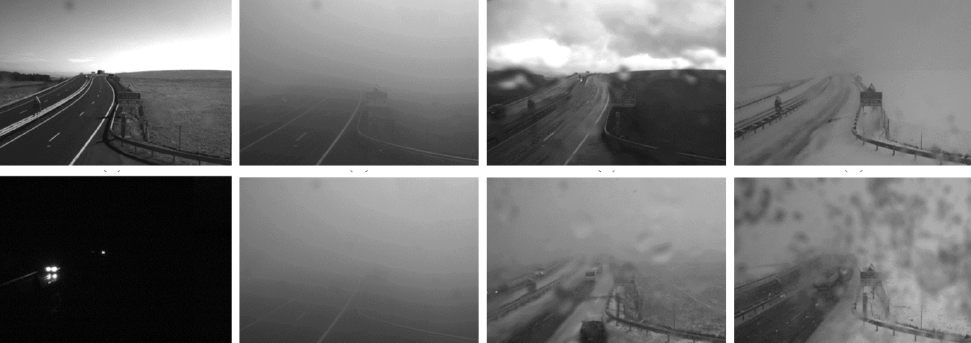
Figure 1. Examples of images from the Cerema-AWH database. The weather conditions presented from left to right: normal conditions, fog, rain and snow